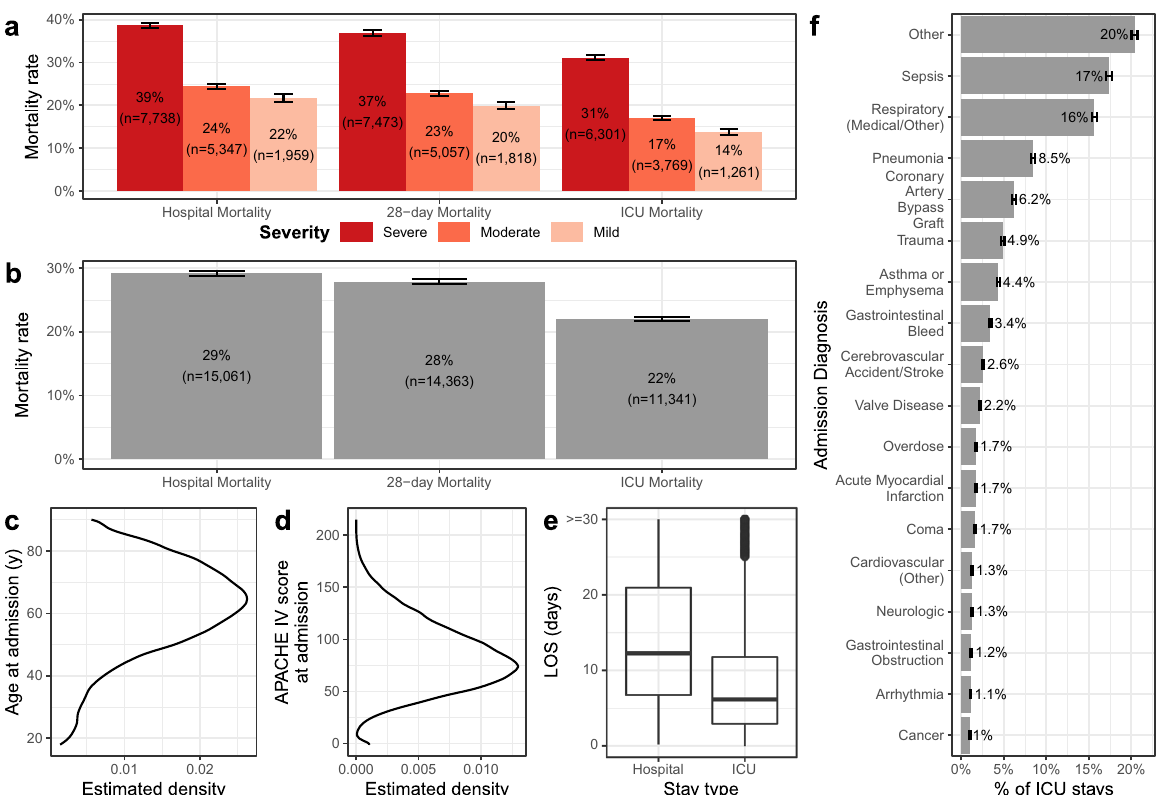
Fig. 3 Characterization of ARDS cohort. The mortality rate by severity at onset ( a ), overall mortality rates ( b ), age ( c ), APACHE IV scores ( d ), lengths of stay (LOS) both in-hospital and in-ICU ( e ), and admission diagnoses ( f ). Severity was determined by the minimum P / F ratio in the fi rst 8 h after ARDS onset. Error bars represent 95% con fi dence intervals. Panels c , d represent estimated densities. e The boxplot elements are: center line, median; box limits, upper and lower quartiles; whiskers, 1.5× interquartile range; points,